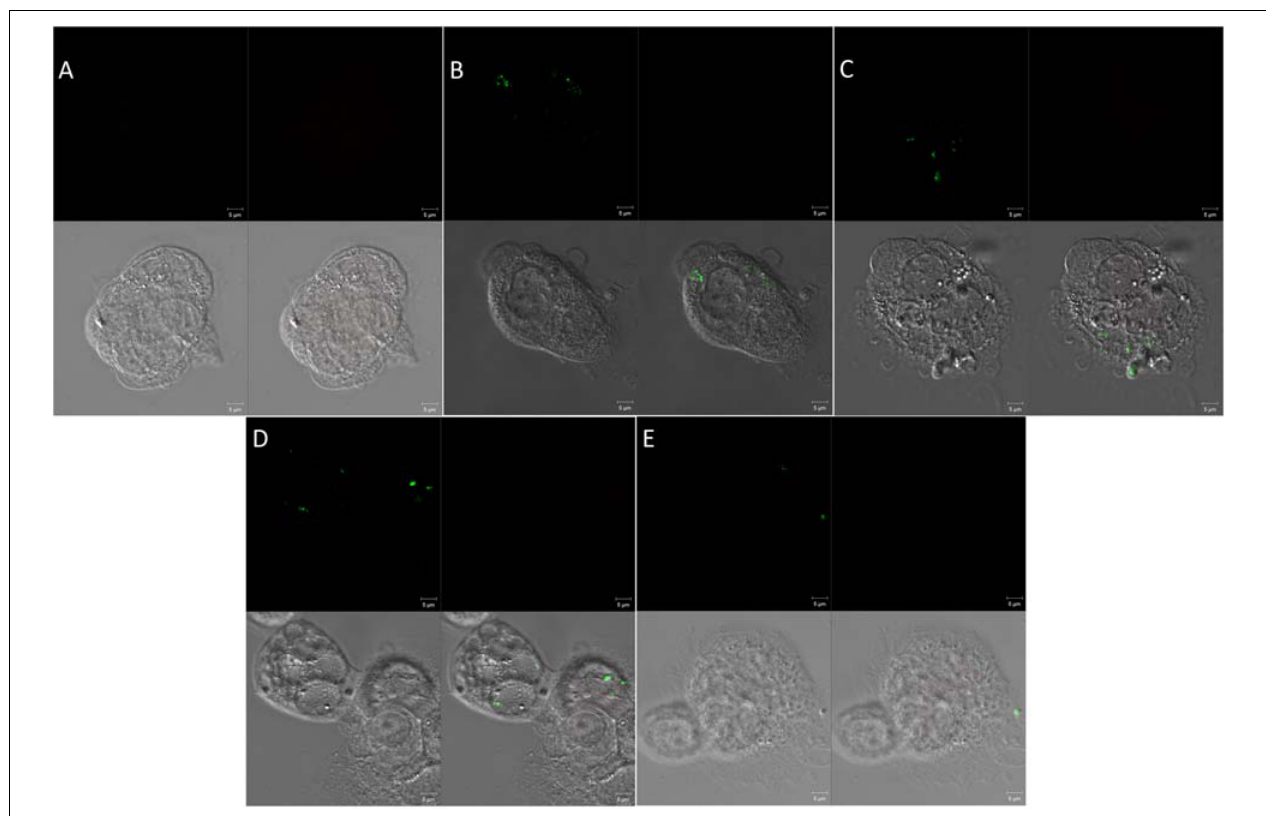
FIGURE 4 | Confocal microscopy of invasion of Caco-2 cells by Salmonella Typhimurium (A) Uninfected cells, (B) cells infected with Salmonella Typhimurium but not treated, (C) Infected cells and treated with sub_MIC of MAR. (D) Cells infected and treated with pyrogallol (30 µ g/mL) and (E) cells infected and treated with pyrogallol and sub-MIC of MAR. The top left panel is a SYTO-9 fluorescence; the top right panel is a propidium iodide fluorescence; the bottom left panel indicates cell structure without fluorescent; the bottom right panel shows a merged image. (Red, dead bacteria; Green, live bacteria; image: × 1,000